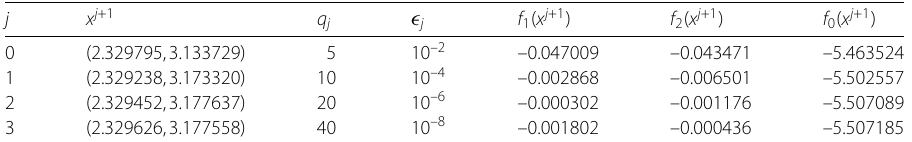
Table 7 Numerical results for Example 4.3 with x 0 = (0,0)